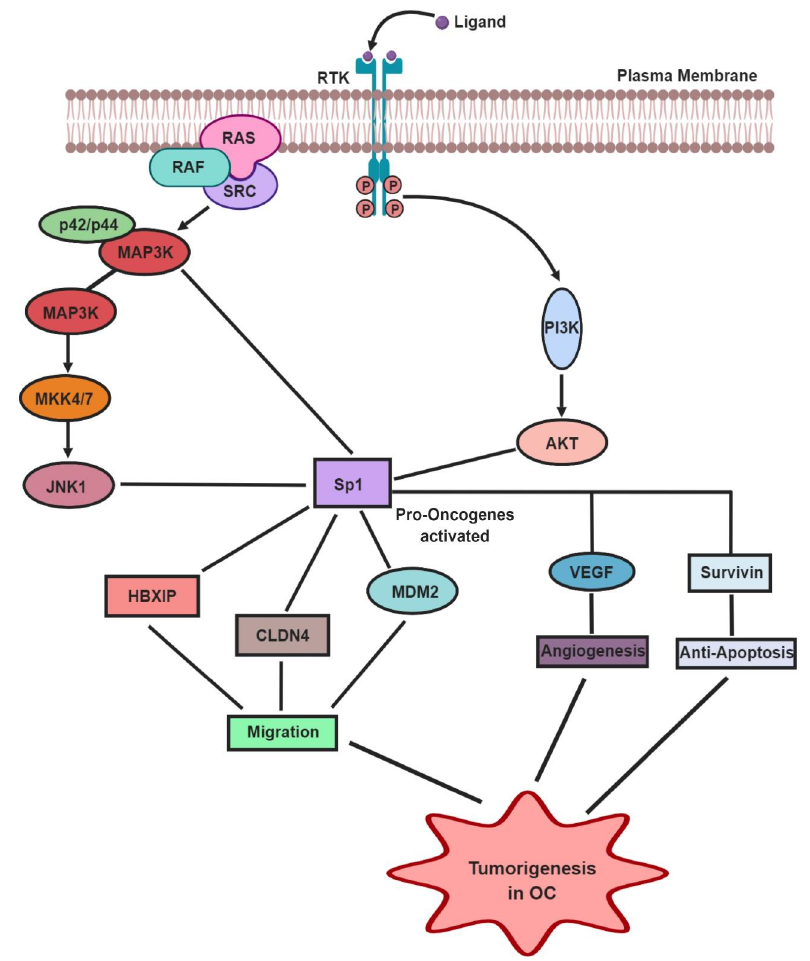
Figure 3. Sp1 mediated tumorigenesis in ovarian cancer (OC). Evasion in the Sp1 transcriptional activities at various levels has been found as a cause for tumorigenesis in OC cells. In OC cells,